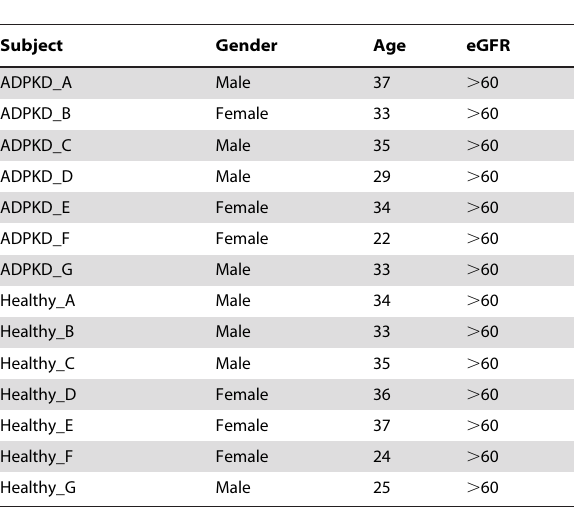
Table 1. Clinical details of ADPKD patients and matched healthy subjects.